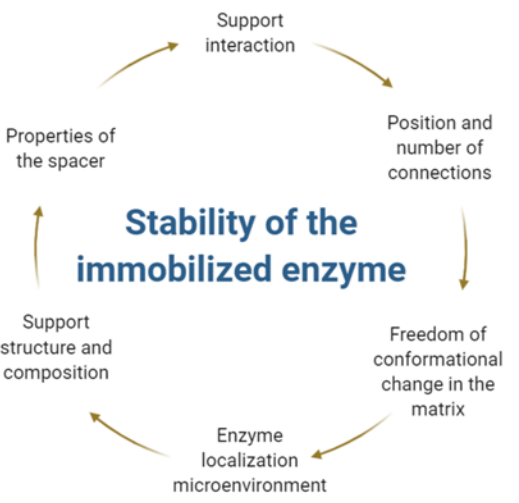
Figure 4. Determining factors for the stability of immobilized enzymes.